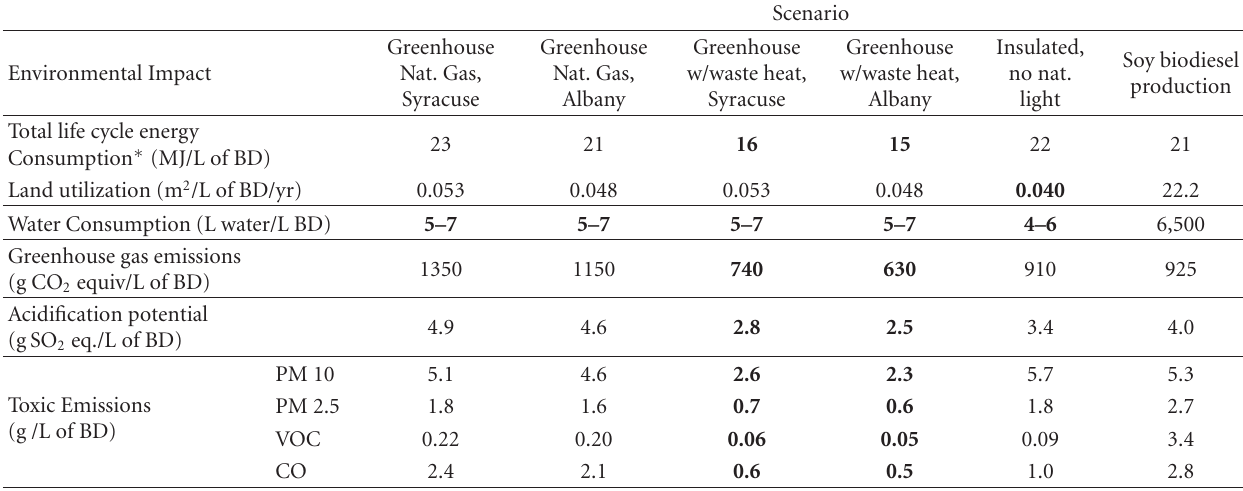
Table 5: Summary of average sustainability metrics to compare algae and soy BD